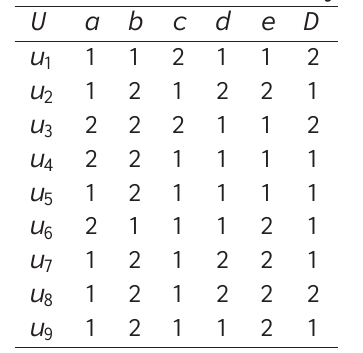
Table 4: An inconsistent decision system S